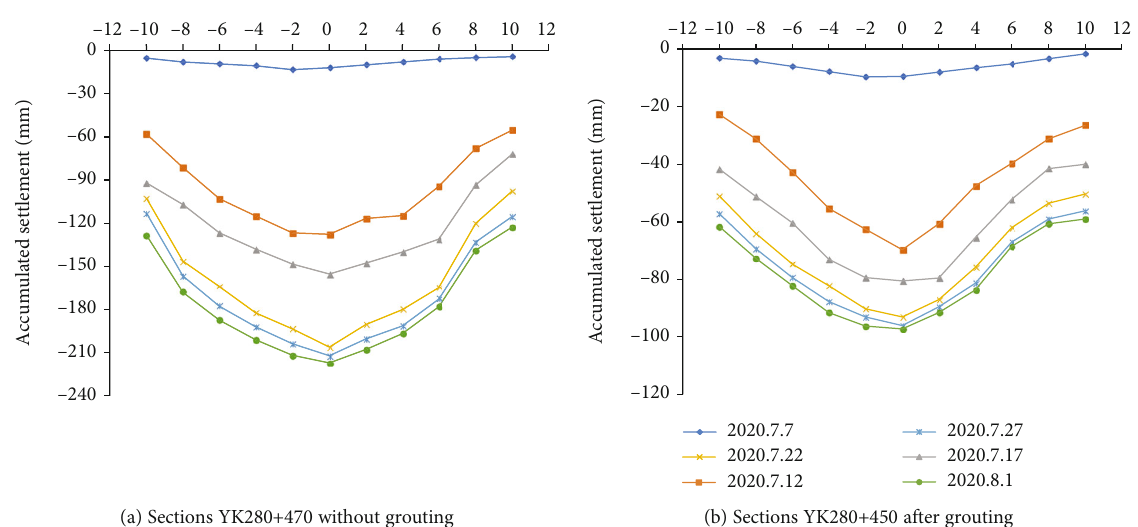
Figure 14: Development diagram of surface transverse settlement of adjacent sections before and after grouting.